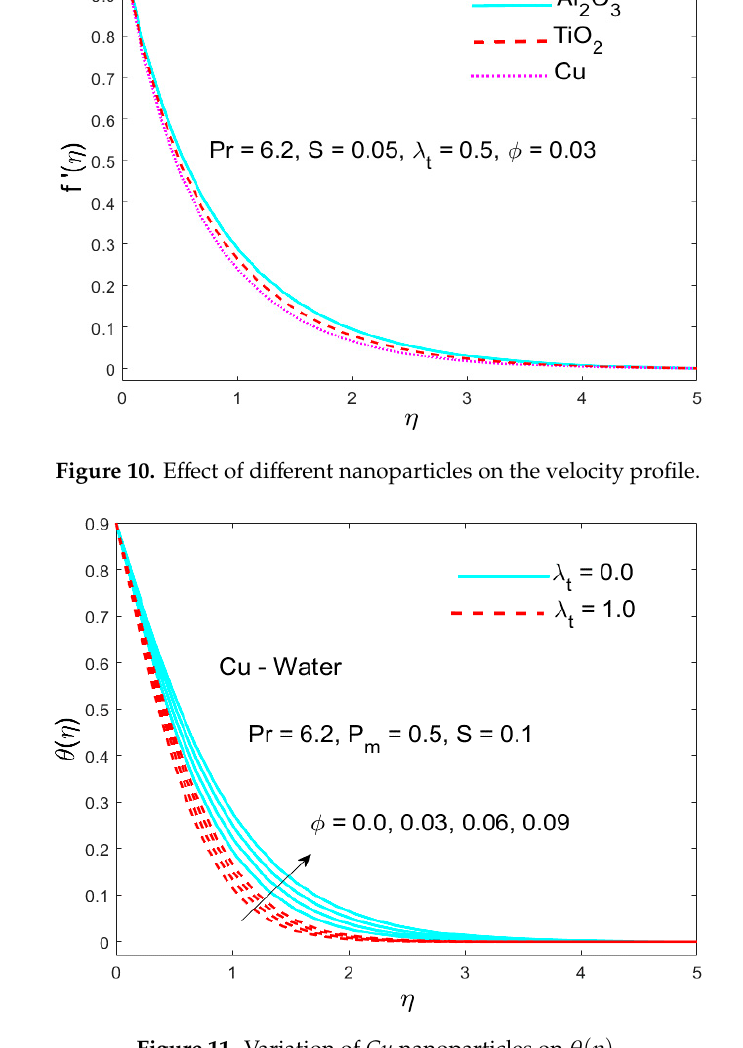
Figure 12. Effect of different nanoparticles on